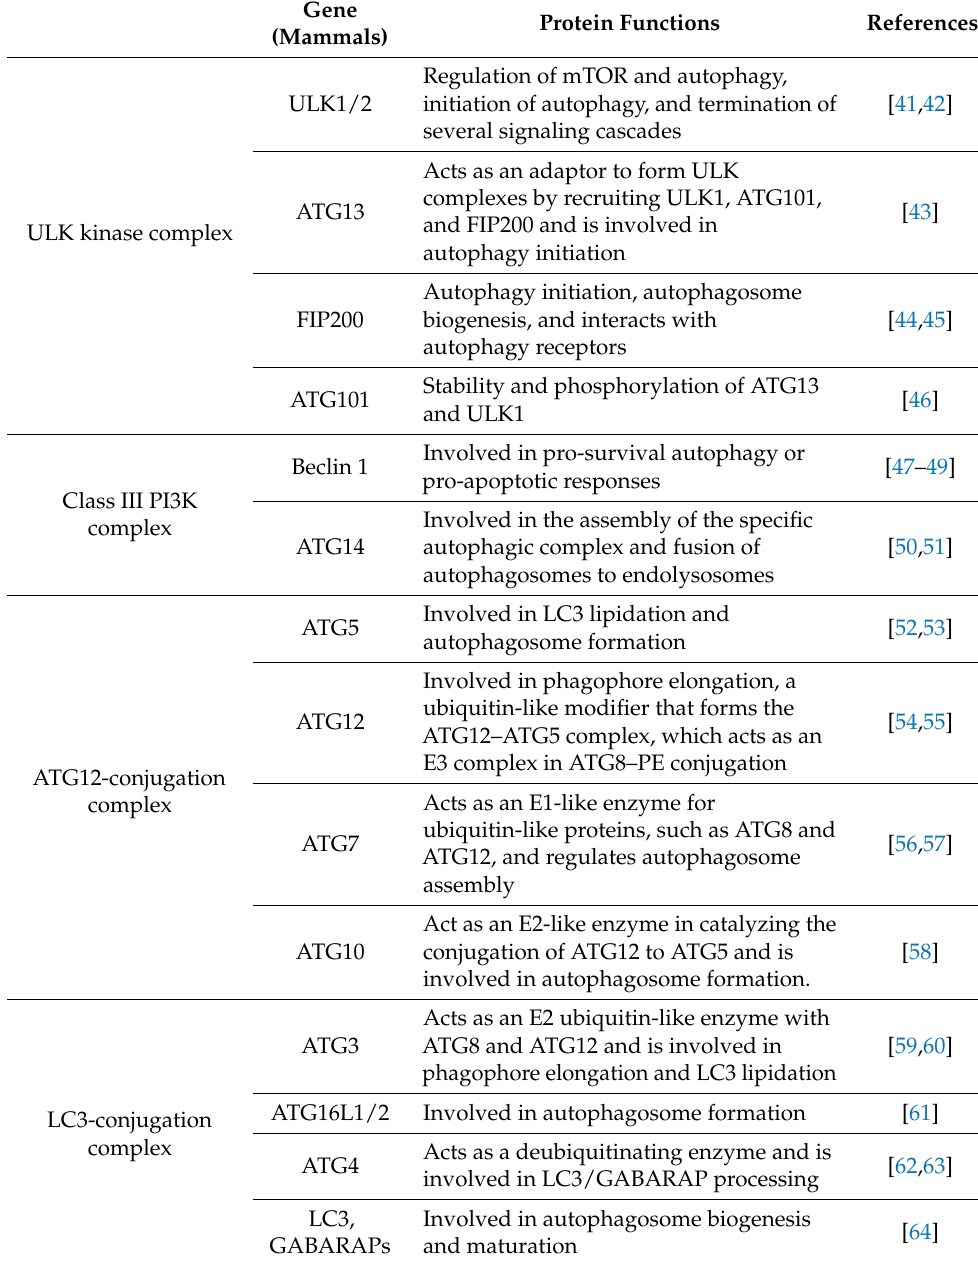
Table 1. Specific roles of ATG proteins in